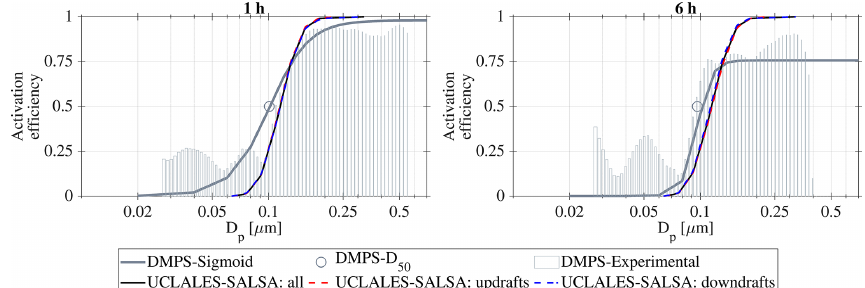
Figure 13. Comparison of activation efficiency curves calculated with UCLALES–SALSA at Puijo altitude of 225m to those retrieved from aerosol number concentrations measured by the twin-inlet DMPS system during case 2 31 October